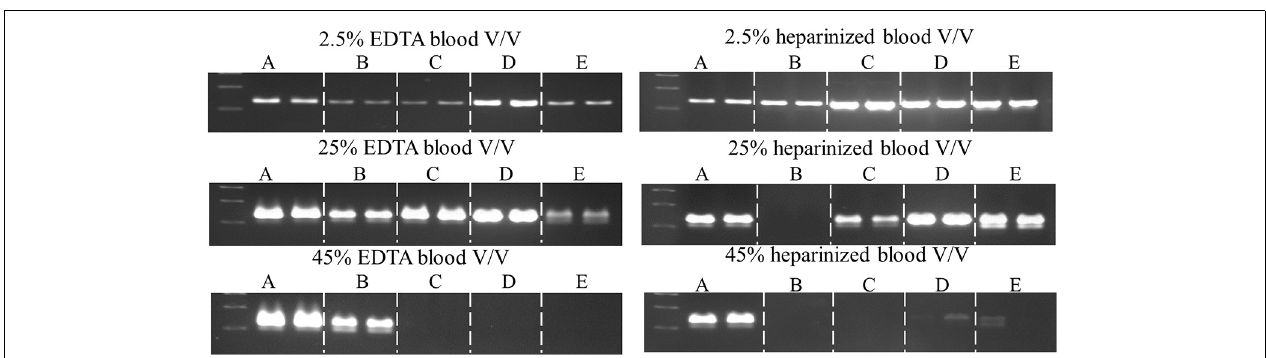
30s at 60 ◦ C, 60s at 72 ◦ C. Wild-type Taq can amplify the 322bp from human genomic DNA in the absence of blood, but not in the presence of 1% blood (data not shown), even though the amount of EDTA introduced with 0.5 μ l EDTA-blood (0.089mM EDTA) is well below inhibitory levels.